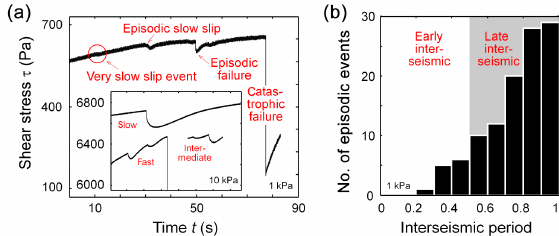
Figure 13. Seismic vs. aseismic slip in a ring-shear test using rice. (a) Slip styles ranging from slow to fast earthquake slip. (b) System- atic increase in slip events towards the end of an analogue seismic cycle. The x axis is a unit interval. Results from ring-shear tests using a Schulze ring-shear tester RST-01 (Schulze, 1994; Fig. 2b). Data and methodological details are published as open-access ma- terial in Rosenau et al.